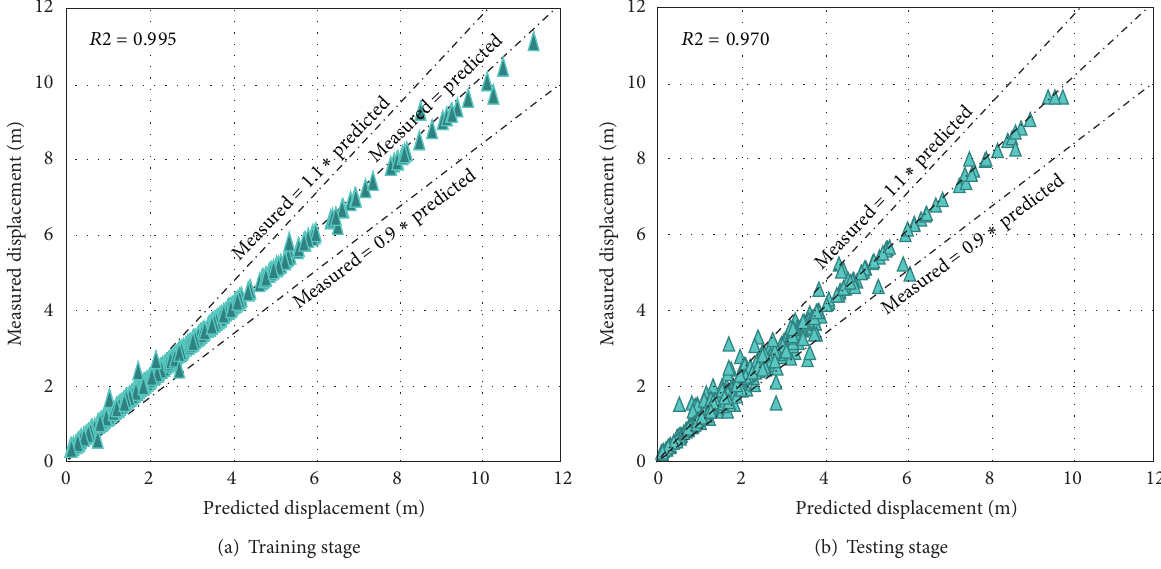
Figure 33: Comparison between neurofuzzy and measured lateral spread, whole dataset. (a) Training stage and (b) testing